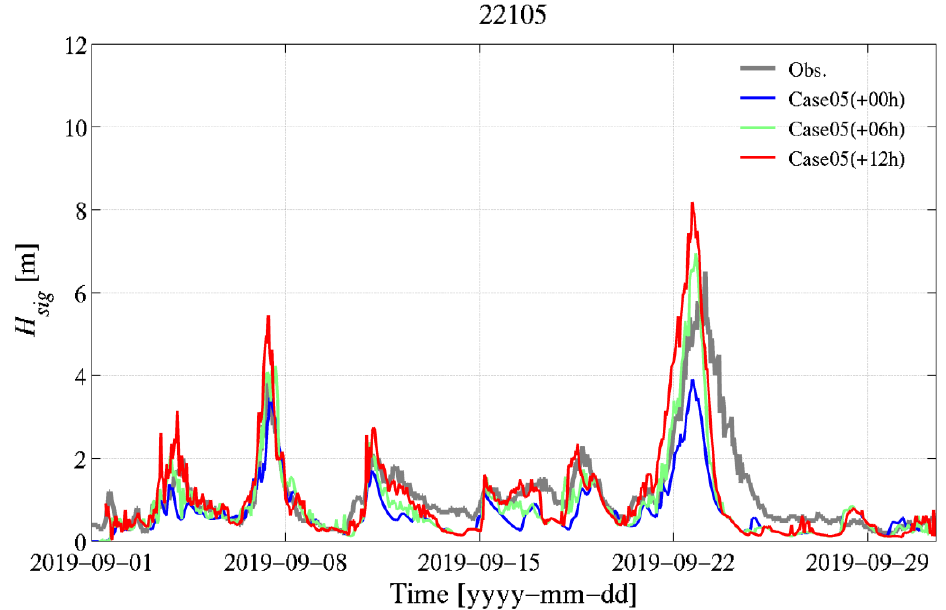
Figure 9. Comparison of the observed and simulated significant wave heights for each forecast lead time at the observation point of 22105.